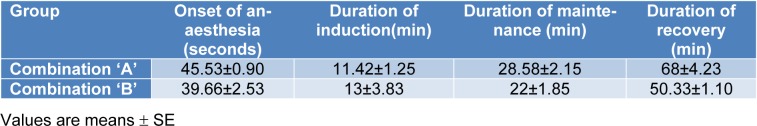
Anaesthetic efficiency of the proposed combinations